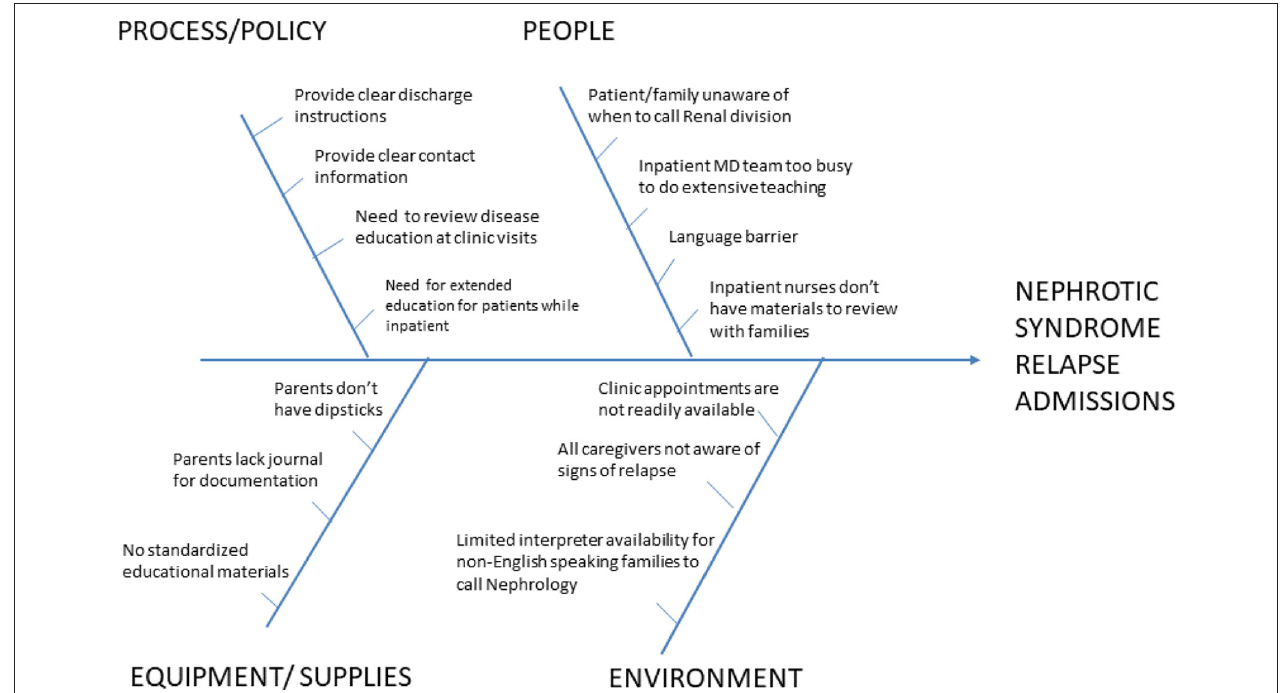
FIGURE 1 | Fishbone analysis of factors contributing to admission for nephrotic syndrome relapse.